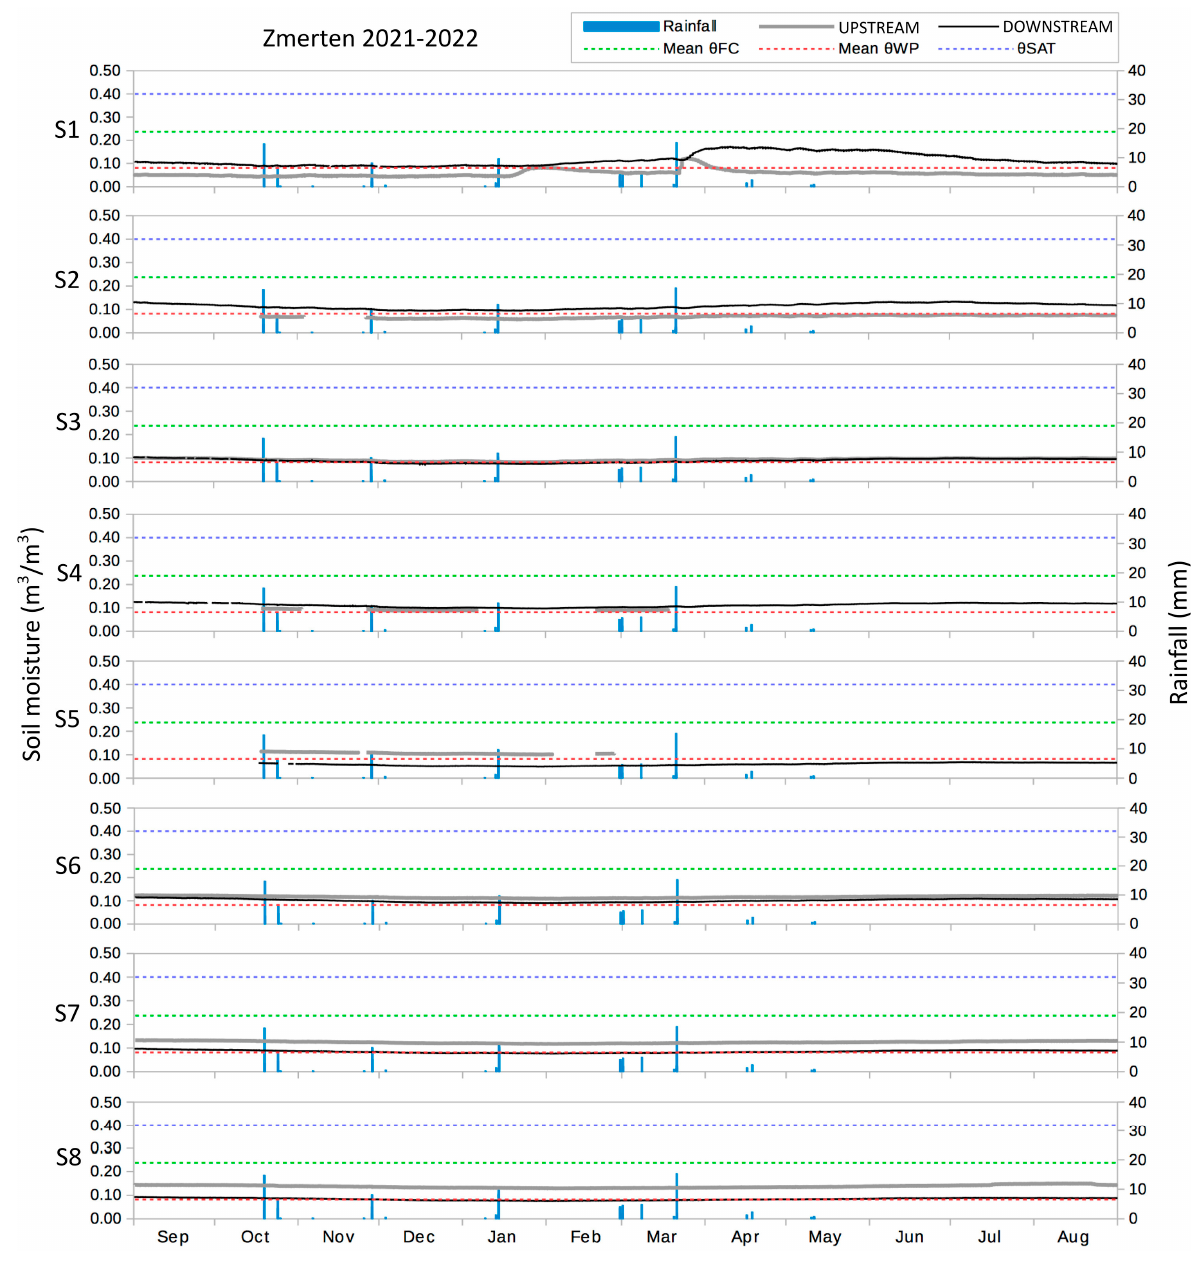
Figure 8. Evolution of soil moisture for the 8 sensors of upstream and downstream Jessour soil pro fi les (2021–22 agricultural year).